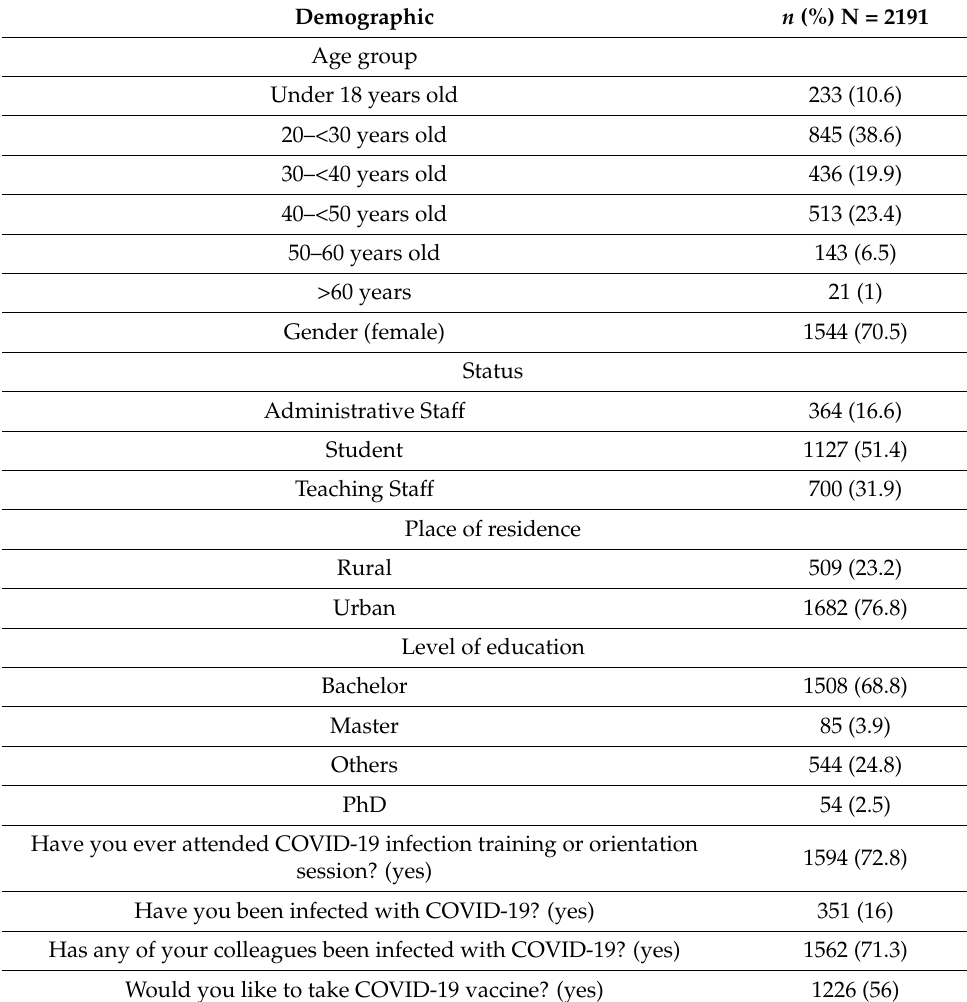
Table 1. Demographics of the survey